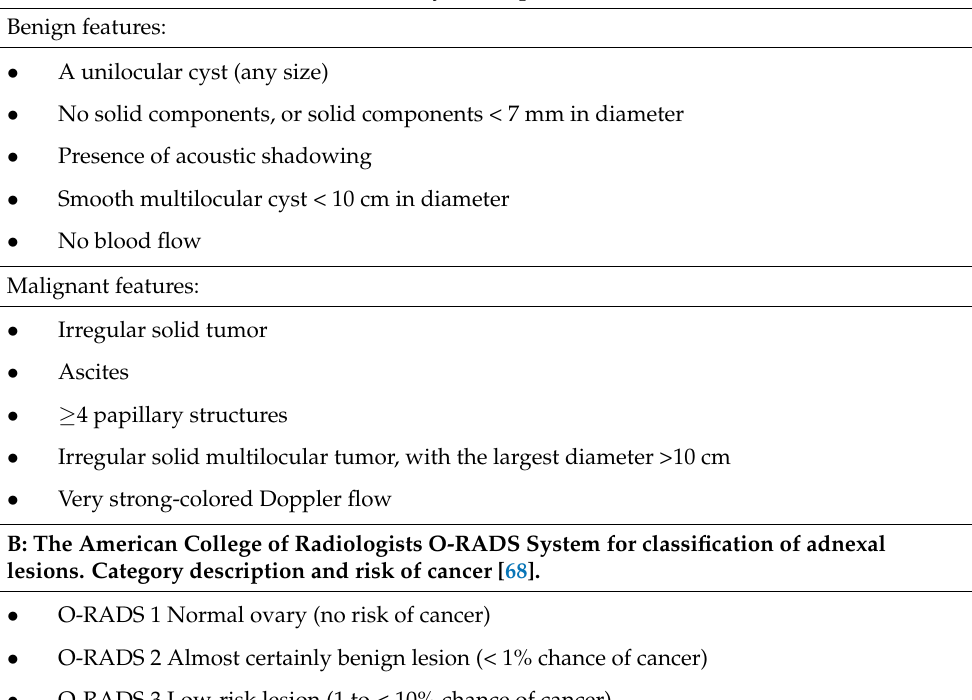
Table 2. Ultrasonographic classification systems employed in the clinical setting to categorize the risk of